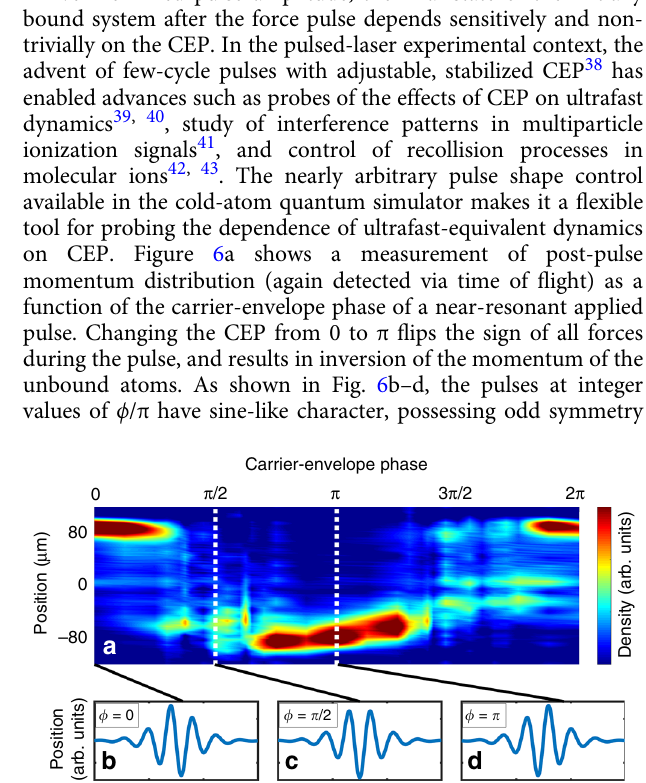
Fig. 4d, with bursts of atoms unbinding at different points during the pulse. Above that intermediate regime, all of the atoms unbind at one well-de fi ned time and continue to move with constant momentum after unbinding. Strikingly, as the amplitude is increased further, the momentum of the unbound atoms reverses sign, as they unbind half a drive cycle earlier, in an oppositely directed simulated electric fi eld.